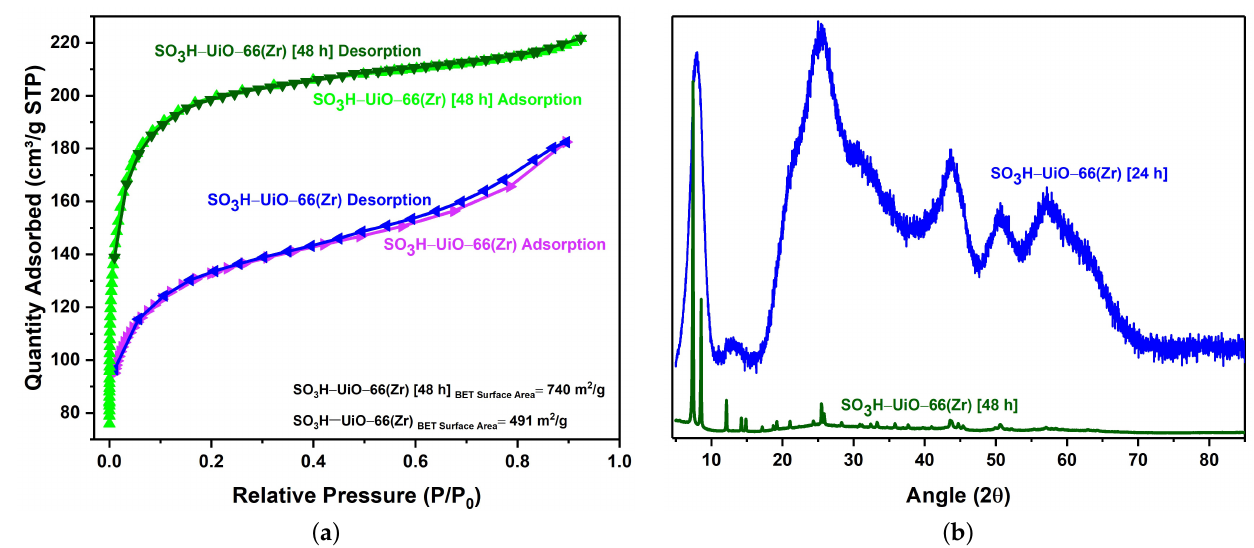
Figure A2. ( a ) N 2 adsorption/desorption isotherms and ( b ) XRD curves of SO 3 H-UiO-66(Zr) [24 h] and SO 3 H-UiO-66(Zr) [48 h] powder.